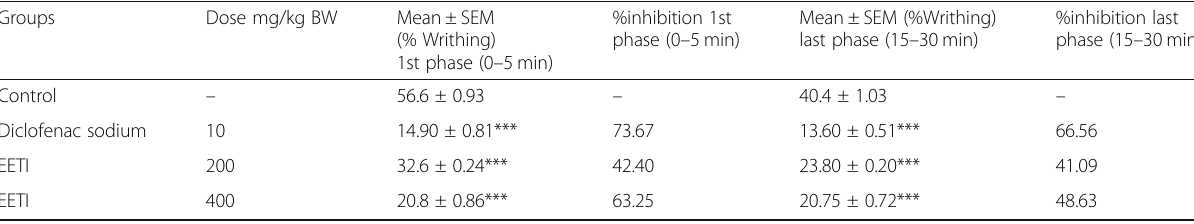
Table 2 Effect of EETI on formalin induced writhing effect in mice Groups